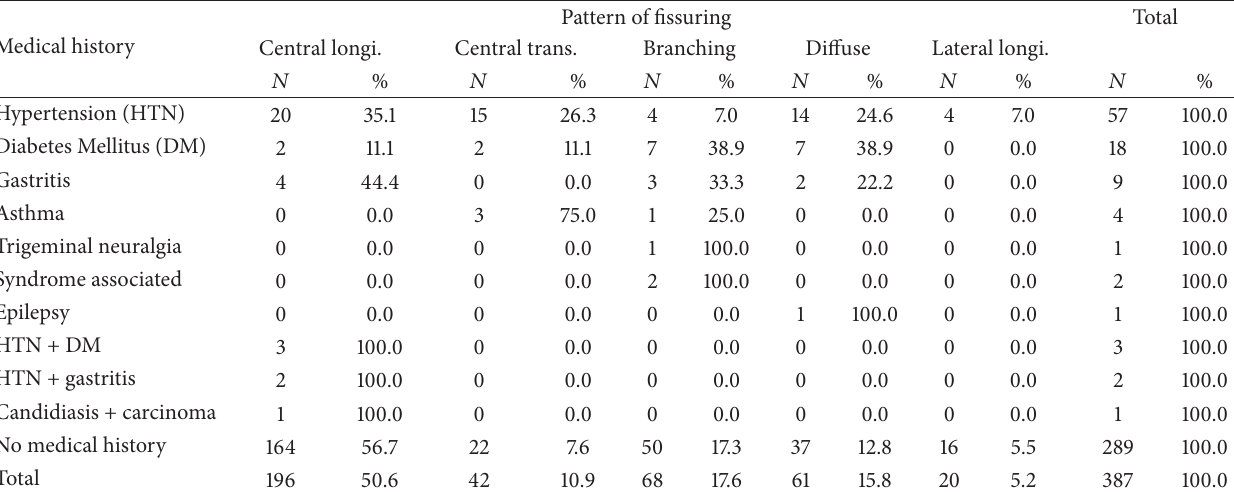
Table 1: Correlation between patterning of fissuring and medical